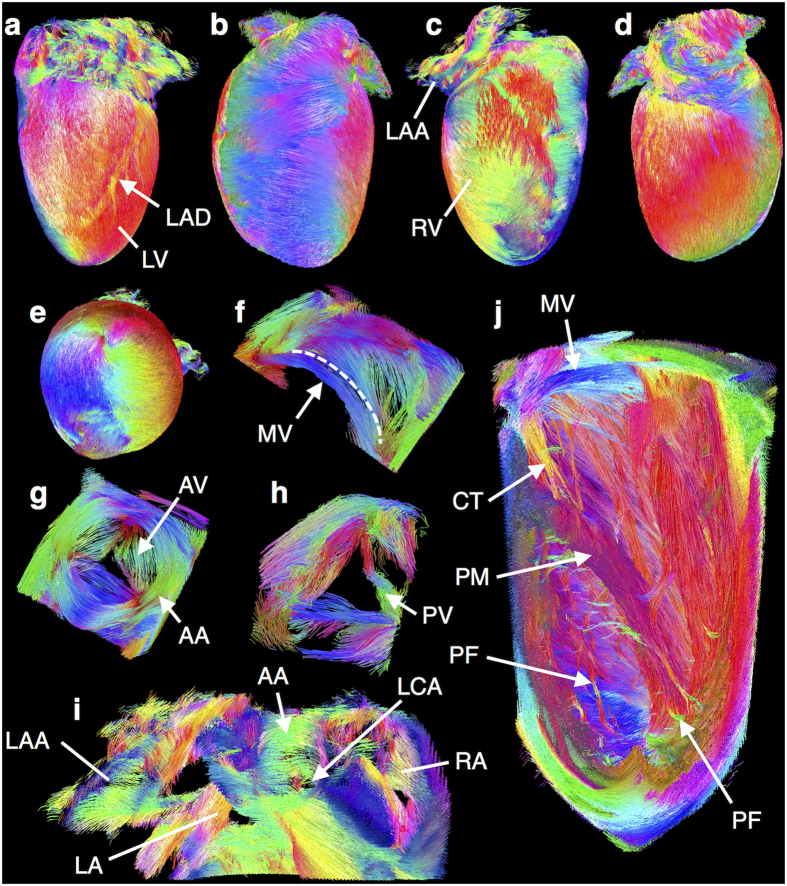
Eigenvector tracking in the whole heart.Tracks were reconstructed based on v1 and colour-coded by orientation: apico-basal (red), anterior-posterior (green) and lateral-septal (blue). Tracks in the heart from (a) lateral, (b) anterior, (c) septal, (d) posterior and (e) apical views. Left helical tracks of the LV subepicardium and circumferential tracks of the RV myocardium are seen. Gaps in subepicardial tracks correspond to the left anterior descending artery (LAD). Tracks can be seen to spiral towards the apex. (f) Tracks in the leaflets of the mitral valve (MV) are primarily oriented parallel to the boundary between leaflets (dashed line). (g) Tracks in the vessel wall of the aorta (AA) are aligned primarily in a circumferential direction, while in the cusps of the aortic valve (AV) they are oriented in an equilateral configuration before curving basally into their insertions into the aortic wall. (h) The pulmonary valve (PV) comprises three leaflets, with tracks organised in an equilateral configuration. (i) Tracks in the left and right atria (LA and RA), and left atrial appendage (LAA) viewed from the septal wall. The left coronary artery (LCA) is seen extending from the aorta and tracks in its vessel walls are aligned circumferentially. (j) Tracks in a 13 × 5 × 5 mm section in the LV reveal chordae tendinae (CT), oriented longitudinally between their connections to the mitral valve and papillary muscle (PM). Networks of Purkinje fibres (PF) can be seen towards the apex.